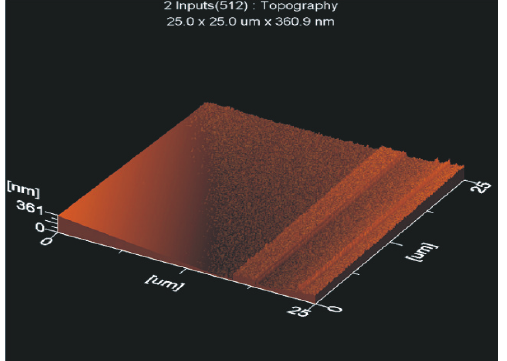
Figure 22. AFM micrograph of a CVD film of parylene N, deposited at 38 mTorr (5 Pa), exhibiting a medium-rough